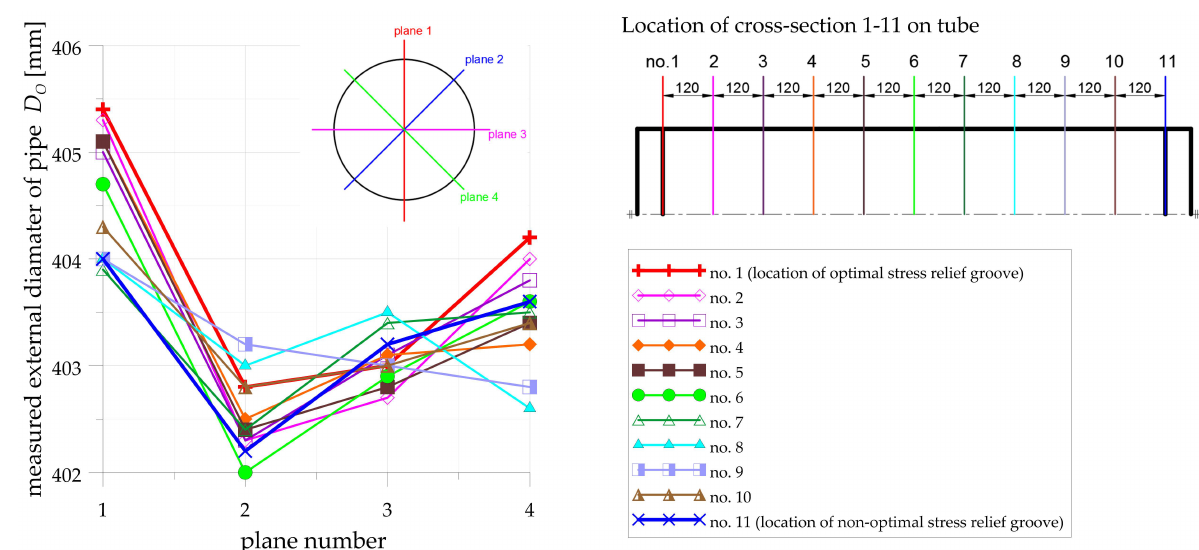
Figure A3. Measured diameters of cylindrical pipe of vessel in different cross-sections.